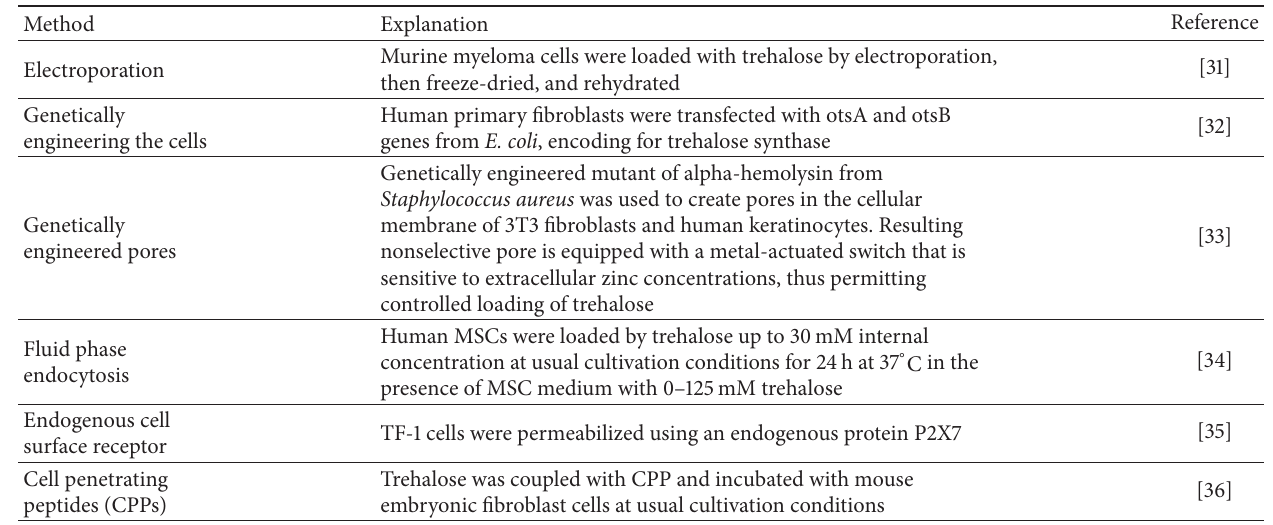
Table 2: Different methods to deliver trehalose into